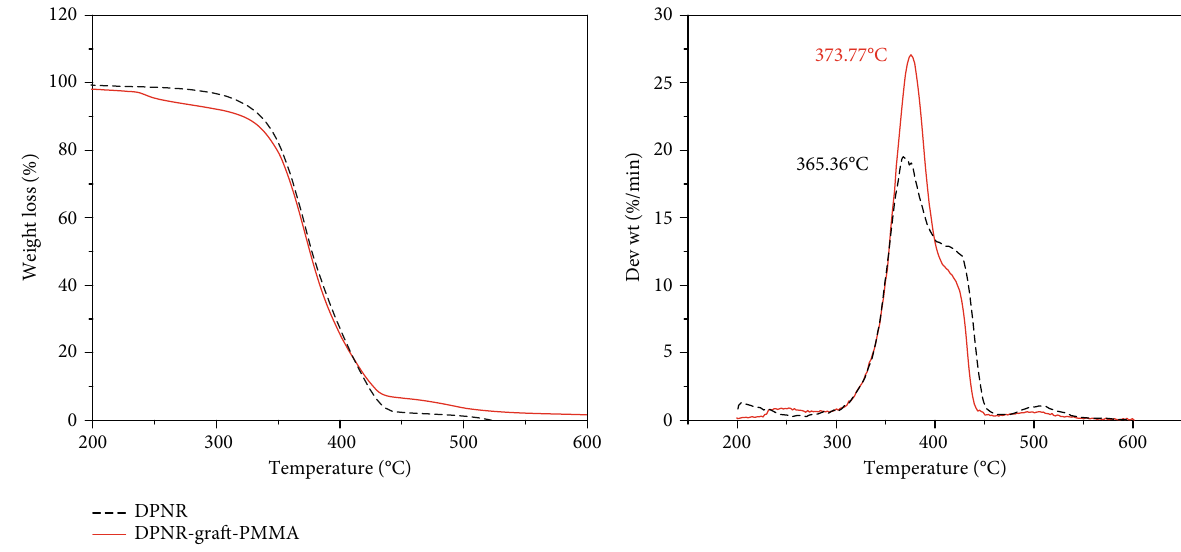
Figure 7: TGA thermograms under argon atmosphere of DPNR and DPNR-graft-PMMA 15